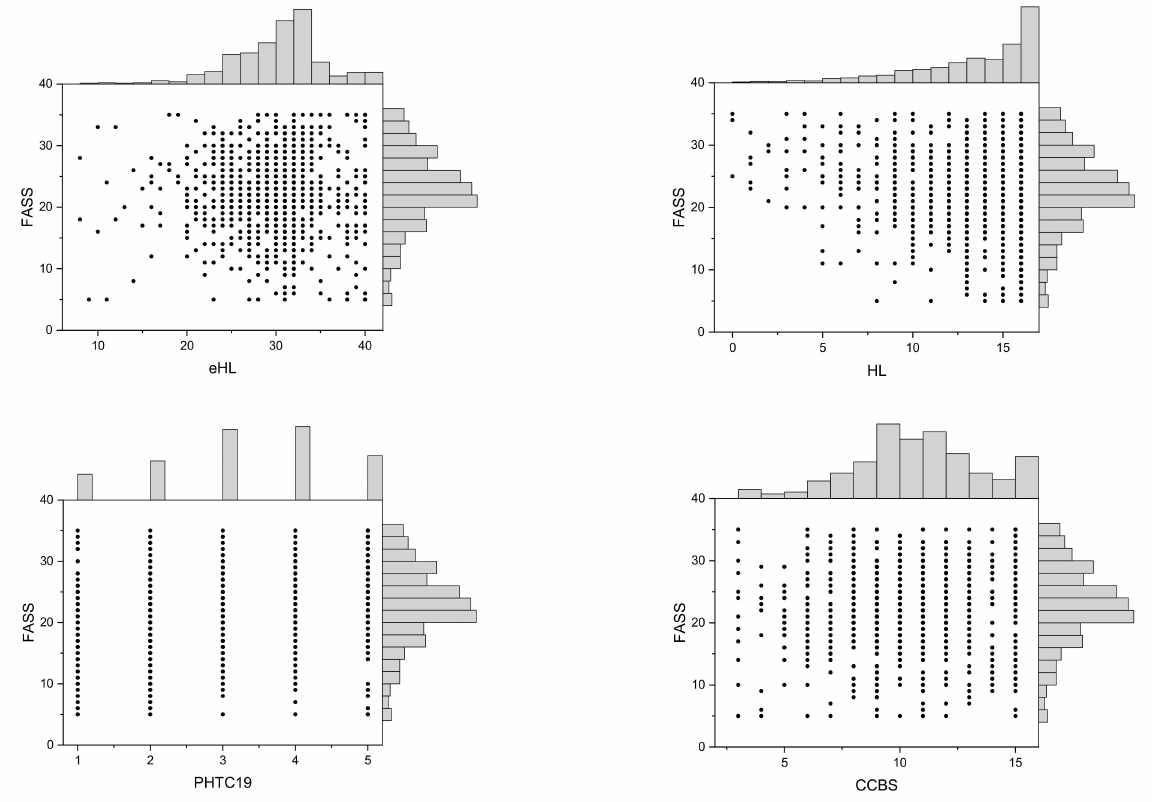
Figure 1. Scatterplots with marginal histograms for FASS and selected independent variables (abbreviations: FASS— future anxiety scale score, HL—health literacy, eHL—ehealth literacy, PHTC19—the perceived health threat related to the COVID-19 pandemic; CCBS—COVID-19-related conspiracy belief